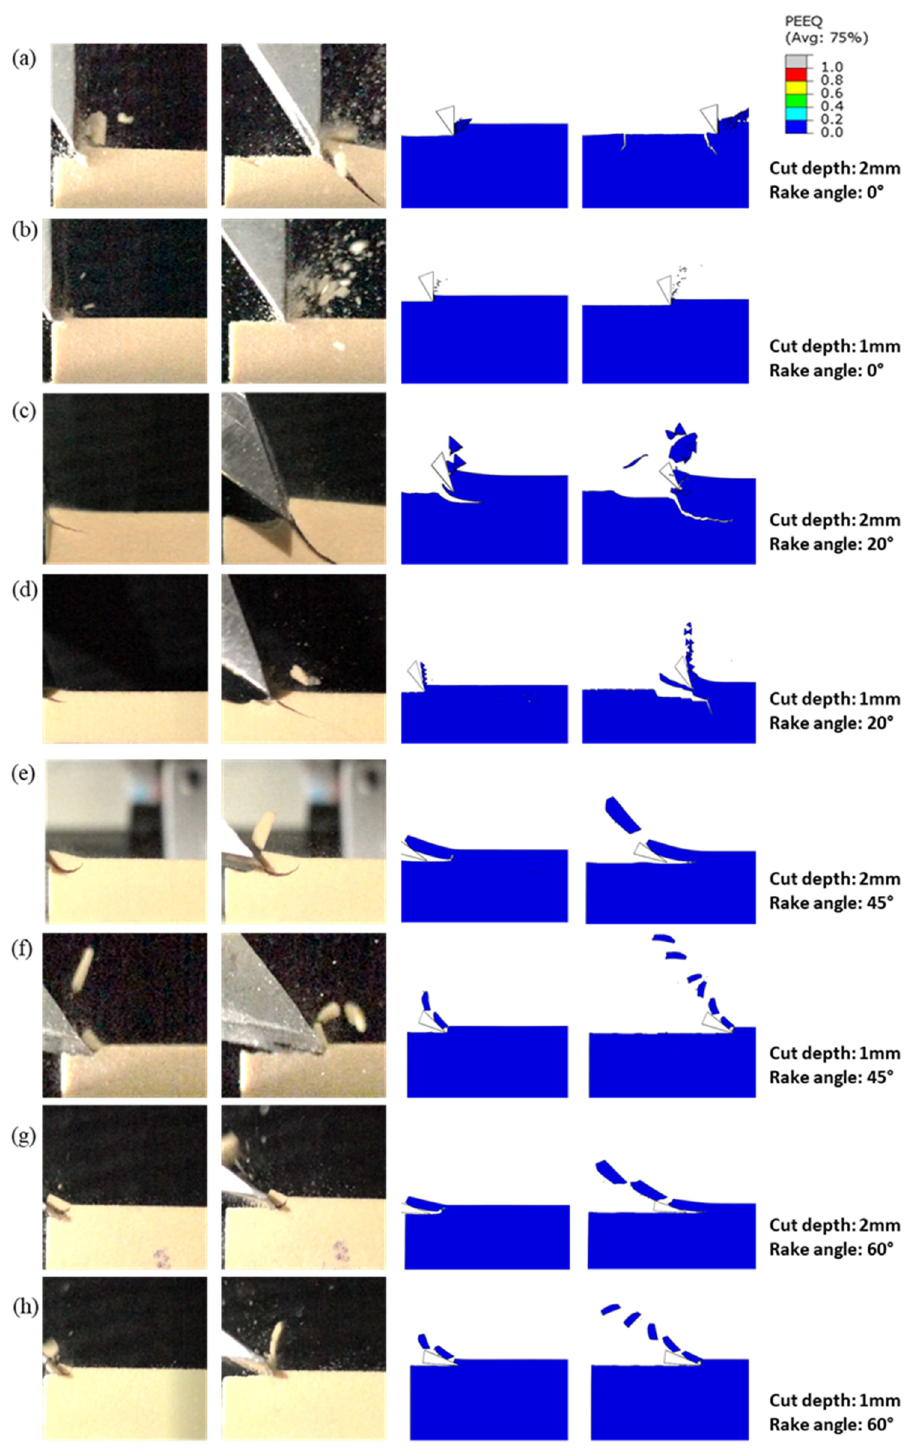
Figure 5. Visual comparison between experimental and computational (CFI model) analyses during orthogonal cutting of PU20 for a range of cutting parameters. Equivalent plastic strain (PEEQ) shown in computational images: ( a ) 𝛼 = 0°, ℎ = 2 mm ; ( b ) 𝛼 = 0°, ℎ = 1 mm ; ( c ) 𝛼 = 20°, ℎ = 2 mm ; ( d ) 𝛼 = 20°, ℎ = 1 mm ; ( e ) 𝛼 = 45°, ℎ = 2 mm ; ( f ) 𝛼 = 45°, ℎ = 1 mm ; ( g ) 𝛼 = 60°, ℎ = 2 mm ; ( h ) 𝛼 = 60°, ℎ = 1 mm .